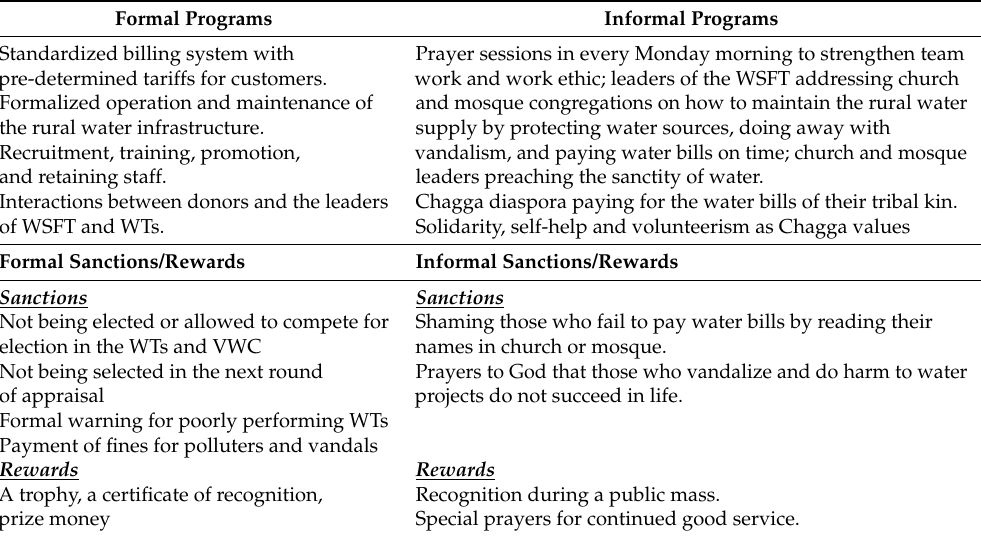
Table 5. Summary of formal and informal programs/sanctions and rewards in Hai and Siha (Source: Fieldwork data,